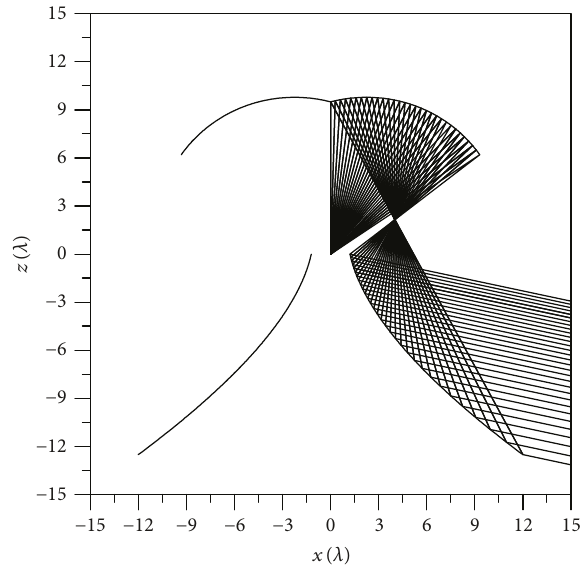
Figure 3: Model for the TEM feed radiation pattern.